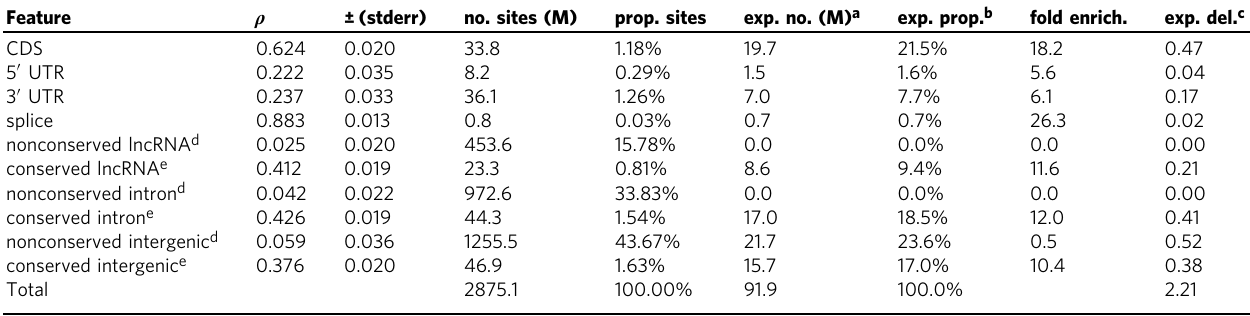
Table 2 Weaker selection across the human genome (based on INSIGHT). Feature